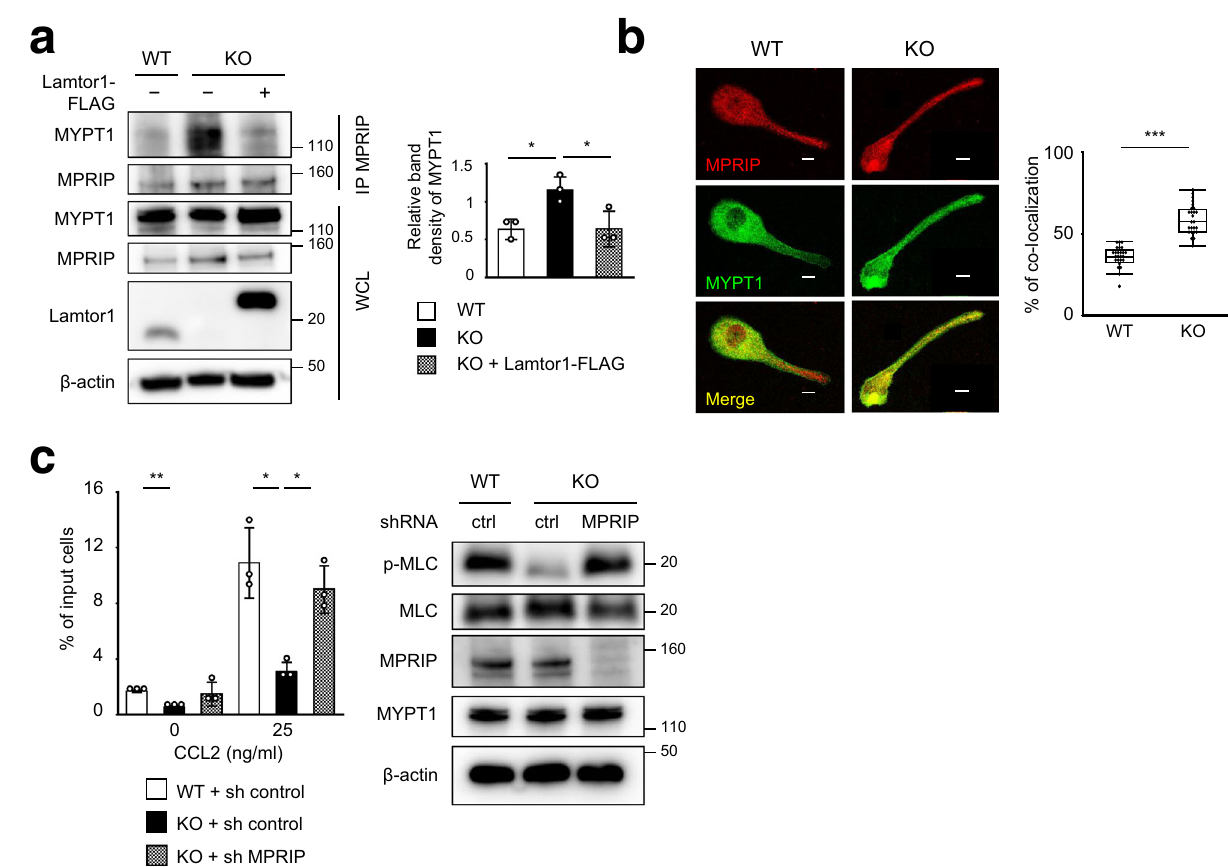
Fig. 5 Interacting of Lamtor1 with MPRIP interferes with the interaction between MPRIP and MYPT1. a Interacting of MPRIP and MYPT1 in the presence or absence of Lamtor1. Parental THP1 cells (WT-THP1), Lamtor1-de fi cient THP1 ( Lamtor1 -KO-THP1), and Lamtor1 -KO-THP1 cells in which full-length Lamtor1-FLAG was re-expressed ( Lamtor1 -KO-Full-THP1) were lysed, precipitated with anti-MPRIP antibody, and detected by western blotting with anti- MYPT1 and anti-MPRIP antibodies (left). Data are representative of three experiments. Concentration of MYPT1 co-precipitated with MPRIP in SDS – PAGE gel bands were determined using ImageJ, and statistical analysis was performed (right). b Co-localization of MPRIP and MYPT1. Localization of MPRIP and MYPT1 in WT and Lamtor1 -KO-THP1 was evaluated by confocal microscopy using anti-MPRIP and anti-MYPT1 antibodies. A representative image of MYPT1 (green) and MPRIP (red) in a polarized cell is shown. Scale bar, 10 μ m (left). Percentage of co-localization of MPRIP and MYPT1 in the tail region of polarized cells ( n = 40) (right). c MLC phosphorylation and chemotaxis of MPRIP-knockdown THP1 cells. WT-THP1 or Lamtor1 -KO-THP1 cells were transduced with control shRNA (WT-sh-ctrl-THP1, Lamtor1 -KO-sh-ctrl-THP1) or MPRIP-shRNA ( Lamtor1 -KO-sh-MPRIP-THP1). Cells were lysed, and the levels of MPRIP, MYPT1, and MLC phosphorylation were detected by western blotting (right). Chemotaxis of WT-sh-ctrl-THP1 (white bar), Lamtor1-KO- sh-ctrl-THP1 (black bar), and Lamtor1 -KO-sh-MPRIP-THP1 (mesh bar) in response to CCL2 (25 ng/ml) was evaluated by Transwell assay (pore size, 5 μ m) (left). Data are representative of three experiments. Statistical analysis was performed by two-sided ANOVA with Tukey ’ s post hoc test ( a , c ) [means ± s. d.; *p < 0.05, ** p < 0.01], or two-sided Mann – Whitney U test ( b ) [median; 25th and 75th percentiles; and minimum and maximum of a population excluding outliers; *** p <